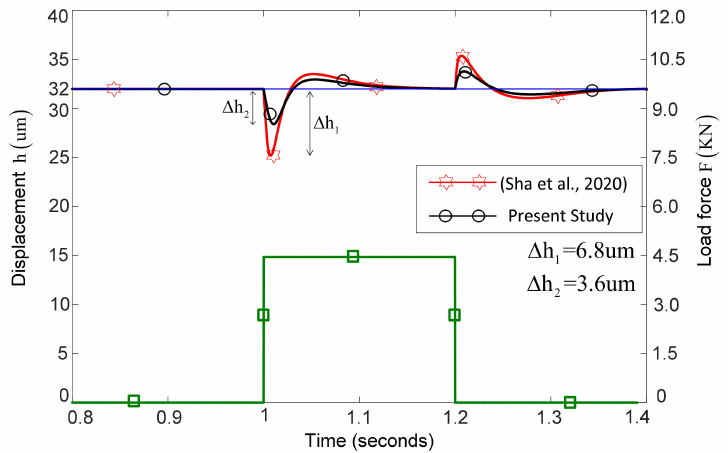
Figure 9. Load rejection